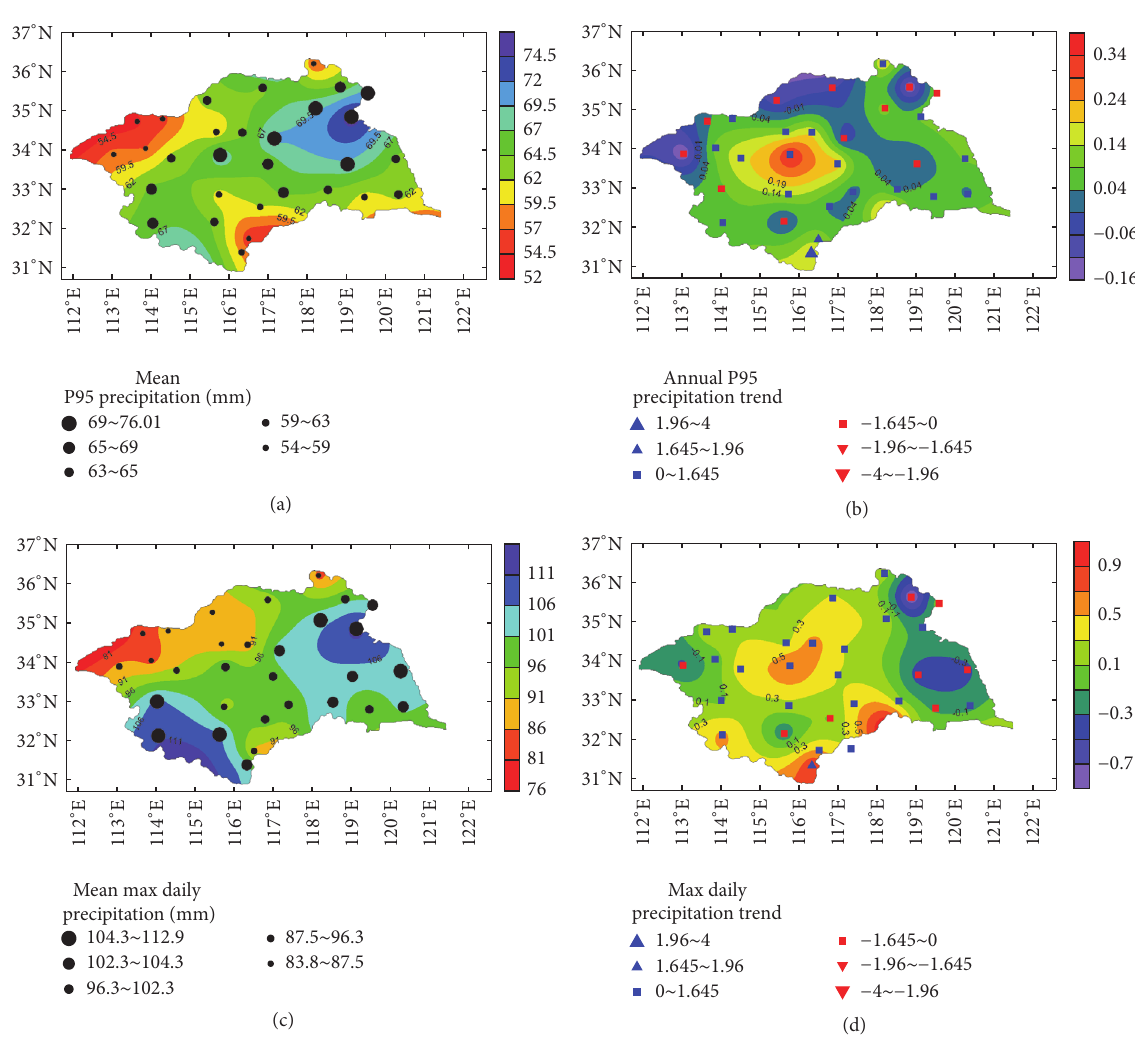
Figure 10: Spatial distribution of the mean of PI95 (a) and its slope and trend (b); maximum daily precipitation (c) and its slope and trend (d).